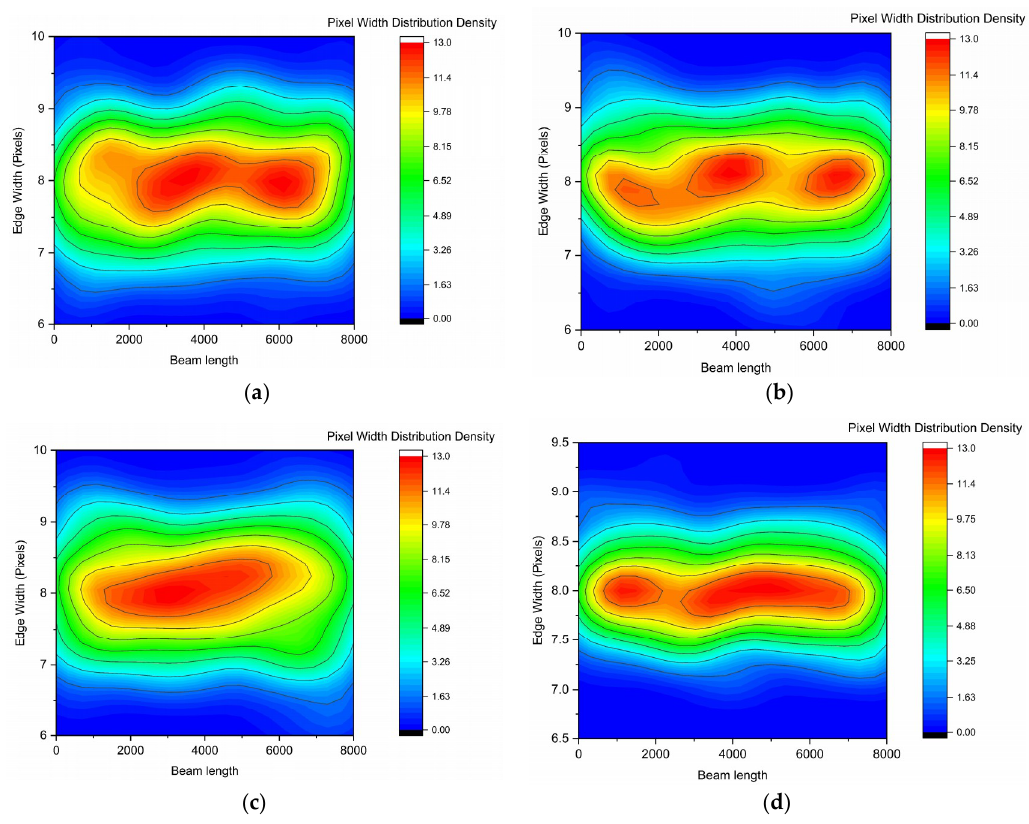
Figure 10. Distribution density of edge pixels by various edge detection operators; ( a ) edge width distribution degree of Sobel operator; ( b ) edge width distribution degree of Prewitt operator; ( c ) edge width distribution degree of Robert operator; ( d ) edge width distribution degree of log operator.